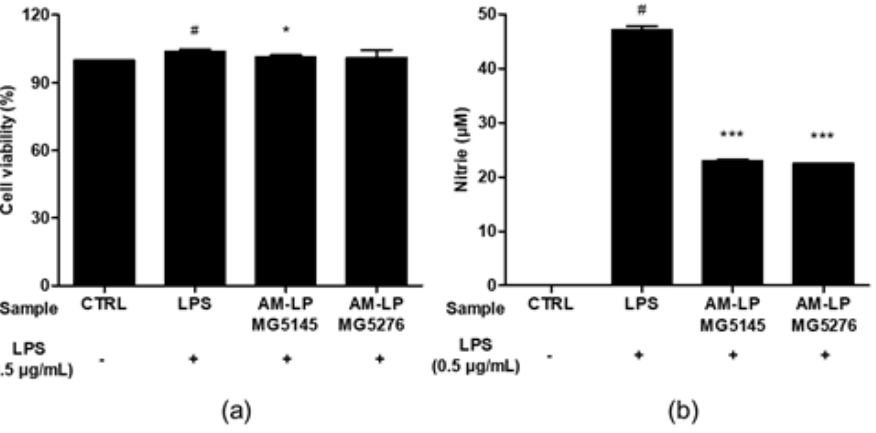
Figure 4. Effect of AM-LP MG5145 and AM-LP MG5276 on ( a ) Cell viability and ( b ) NO production in LPS-induced RAW 264.7 cells. Cells were treated with 20% ( v / v ) samples and LPS (0.5 μg/mL) for 24 h. Data are represented as the mean ± SD ( n = 3). # p < 0.05 compared to untreated LPS control. * p < 0.05 and *** p < 0.001 compared to treated LPS control.